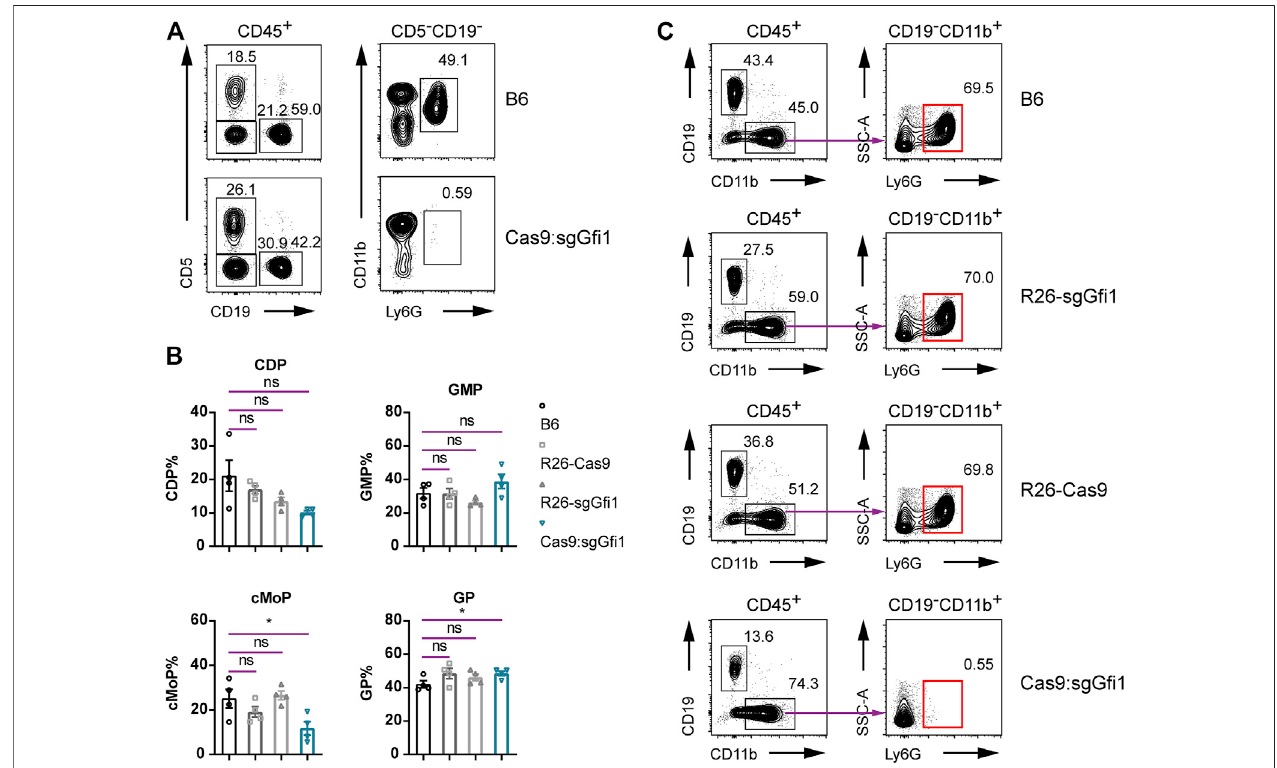
FIGURE 4 | Immunophenotyping of Cas9:sgG fi 1 mice. (A) Determination of circulating neutrophils in peripheral blood from Cas9:sgG fi 1 mice analyzed by fl ow cytometry. The gating strategy is the same as that used in Figure 2A . (B) Percentages of BM-derived myeloid progenitors CDP, GMP, cMoP, and GP of WT B6, Rosa26 U6-sgRNA-G fi 1 mice (R26-sgG fi 1), Rosa26-Cas9 mice (R26-Cas9), and Cas9:sgG fi 1 mice, mean ± SEM, n (cid:1) 4. CDP: common DC progenitor; GMP: granulocyte- monocyte progenitor; cMoP: common monocyte progenitor; GP: granulocyte committed progenitor. (C) Representative fl ow cytometric analysis of Ly6G